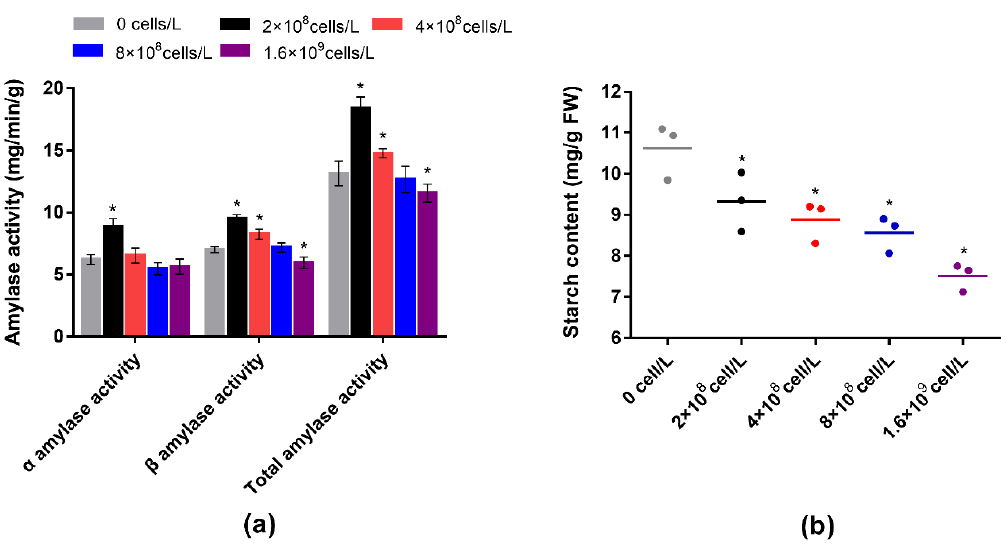
Figure 3. L. punctata amylase activity and starch content after co-culturing with M. aeruginosa . ( a ) α , β , and total amylase activity. ( b ) Starch content. Values are means ± SE from three biological replicates. Asterisks indicate statistical significance based on one-way ANOVA; * p < 0.05.